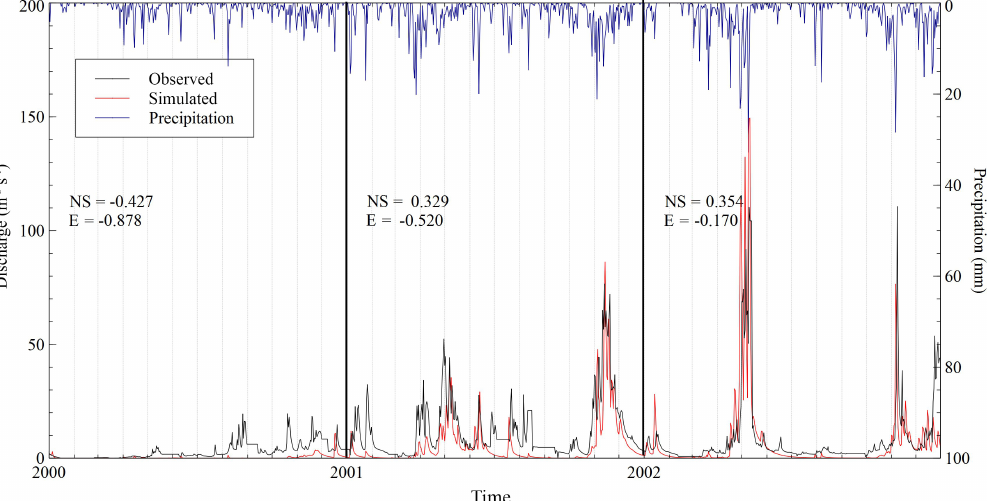
Figure 7. Time series of rainfall and observed and simulated daily discharge (m 3 s − 1 ) during the validation period (2000, 2001 and 2002).